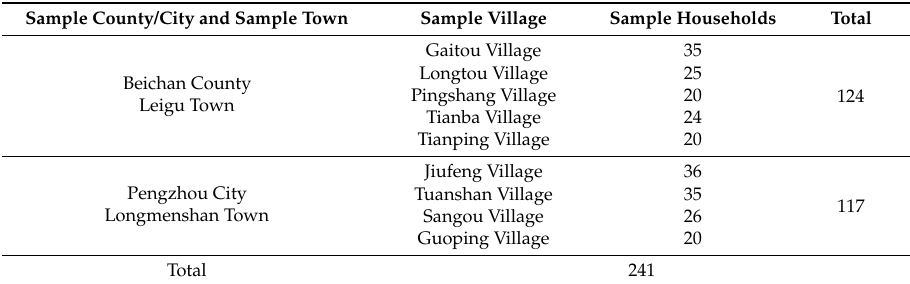
Table 1. Summary statistics for sample farming households in sample villages and counties. Sample County/City and Sample